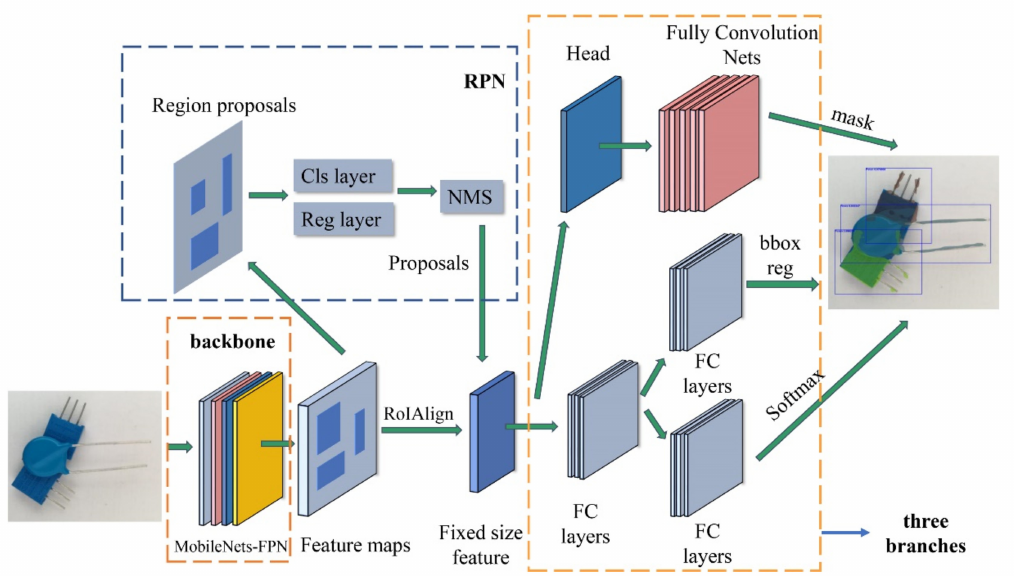
Figure 10. The overall structure of the improved Mask R-CNN. RoIAlign: Region of Interest